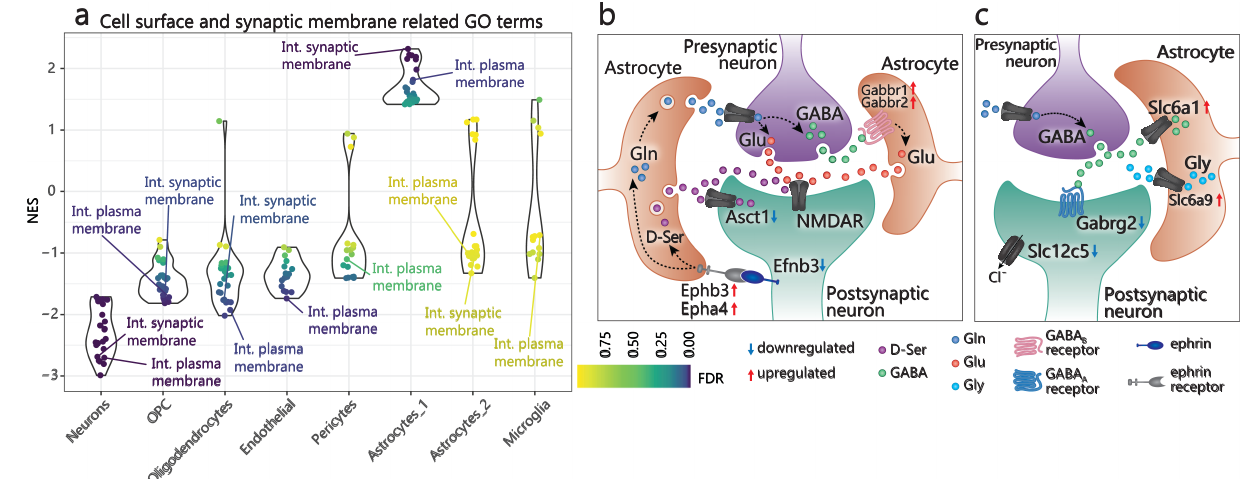
Fig 5. Dysregulated genes in Fmr1 -KO astrocytes and neurons involved in synaptic functions. a) Comparison of normalized enrichment scores (NES) across cell types for all GO terms that show opposite signals in astrocytes and neurons (e.g. Int. synaptic membrane = Integral component of synaptic membrane, GO:0099699; Int. plasma membrane = Intrinsic component of plasma membrane, GO:0031226). b-c) Summary diagram of strongest dysregulated genes in astrocytes and neurons involved in synaptic signaling and regulation which suggest an increased release of excitatory (b) and a higher clearance of inhibitory (c) gliotransmitters and neurotransmitters in the synaptic environment. D-Ser = D-Serine; GABA = Gamma aminobutyric acid; Gln = Glutamine; Glu = Glutamate; Gly = Glycine.